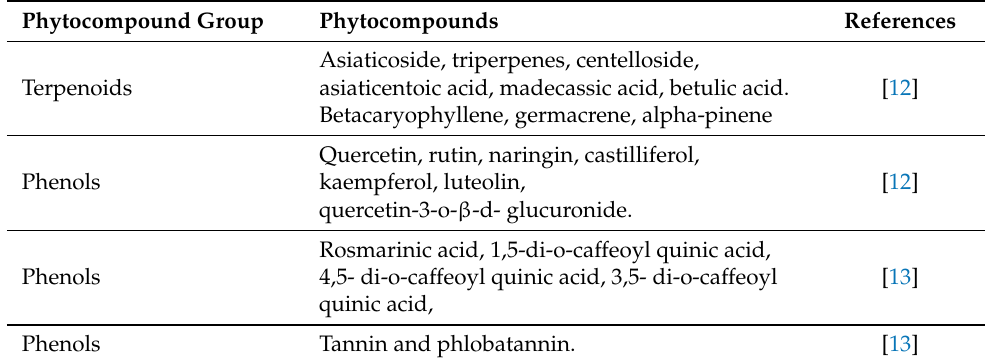
Table 1. Phytocompounds of Centella asiatica